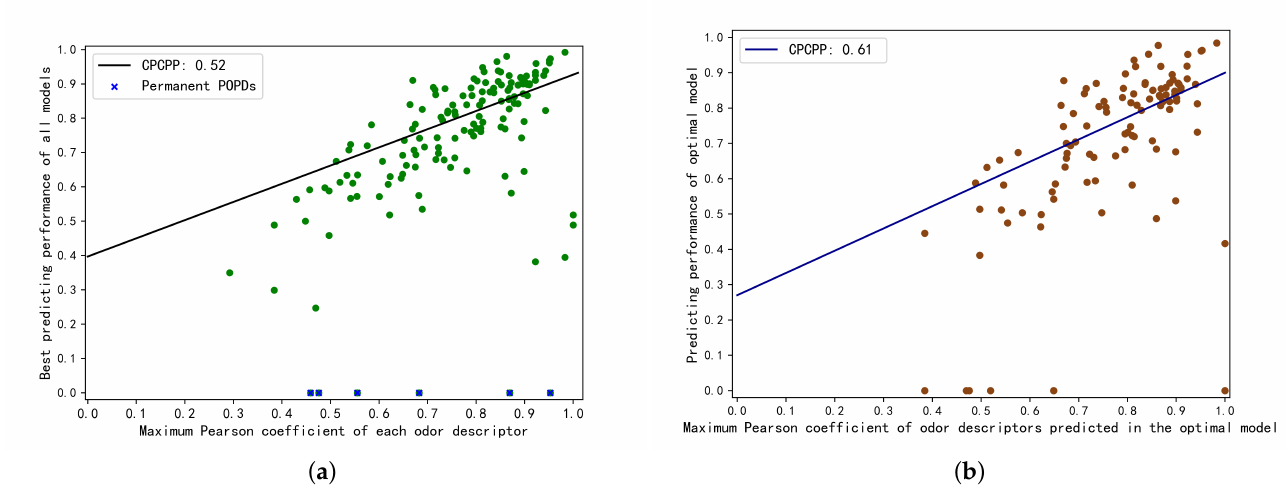
Figure 13. The scatter plot of the relationship between the predicting performance and the maximum Pearson correlations of the odor descriptors in the optimal configuration. CPCPP is the abbreviation for correlation between Pearson correlation and predicting performance. ( a ) Scatter plot of best predicting performance under the optimal configuration and the maximum Pearson correlation coefficient of each of the 146 odor perception descriptors. ( b ) Scatter plot of the predicting performances and the maximum Pearson correlation coefficients of the 105 NCCOPDs in the optimal